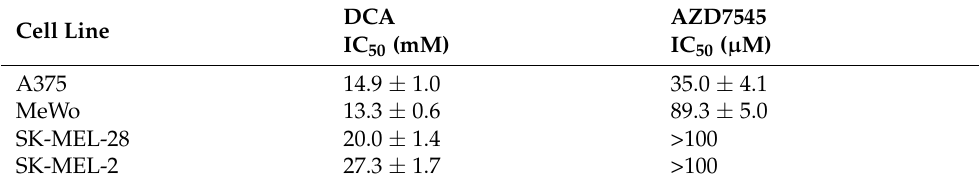
Figure 1. Effect of PDK inhibition on melanoma cell proliferation. ( A ) Viability curves after 96 h of treatment with DCA in all cell lines. Viability curve of A375 cells grown in Matrigel treated with DCA for either ( B ) 96 h after 3 days of initial spheroid development or ( C ) treated continuously for 7 days. ( D ) Representative image of Hoechst/Calcein/PI staining of A375 spheroids treated with 14 mM DCA either continuously for 7 days or 24 h after 6 days of initial spheroid formation. 10 × magnification. ( A – C ) Data represent mean ± SD of 3 independent experiments, each performed in triplicate. PI: propidium iodide. Table 1. IC 50 values for DCA and AZD7545